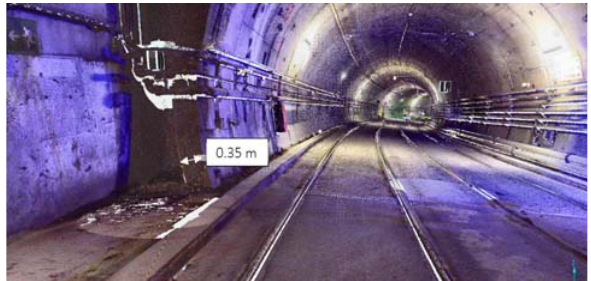
Fig. 5: View of the tunnel and measurement of the thickness of the voussoirs